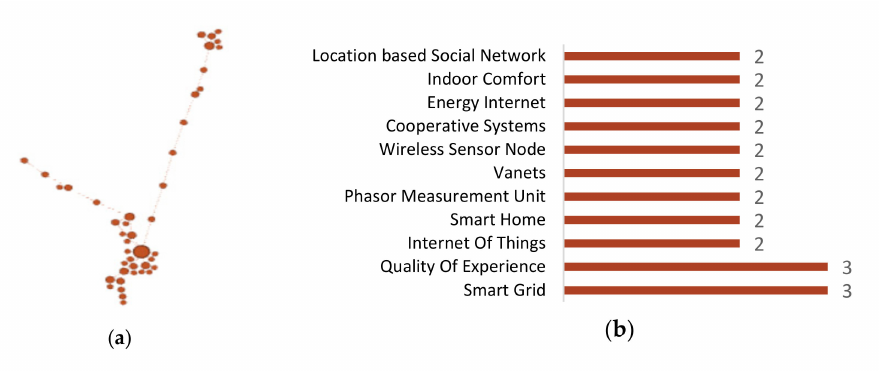
Figure 21. Representation of the Smart City community: ( a ) Isolated distribution of publications. ( b ) Keywords of the